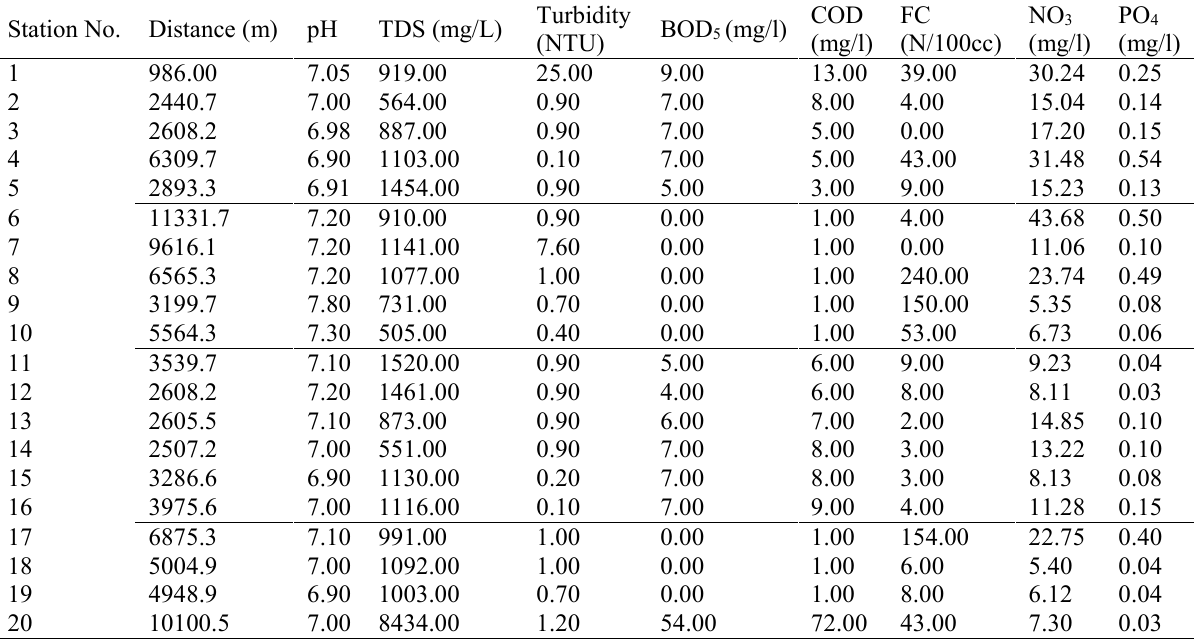
Table 1. Distance of selected wells from Hamedan's landfill and its groundwater quality during the summer months Station No.